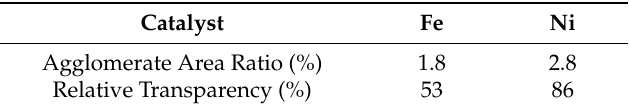
Figure 1. Light microscopy (LM) and TEM images of microtomed cuts of 2.0 wt% nitrogen-doped carbon nanotube/polyvinylidene fluoride (N-CNT/PVDF) nanocomposites with N-CNTs synthesized over different catalysts. LM and TEM images reveal the dispersion state at microscale and nanoscale, respectively. Figure S1 of Supporting materials shows more TEM images of the nanocomposites. Table 1. Agglomerate area ratio and relative transparency of thin cuts of 2.0 wt% N-CNT/PVDF nanocomposites with N-CNTs synthesized over different catalysts.